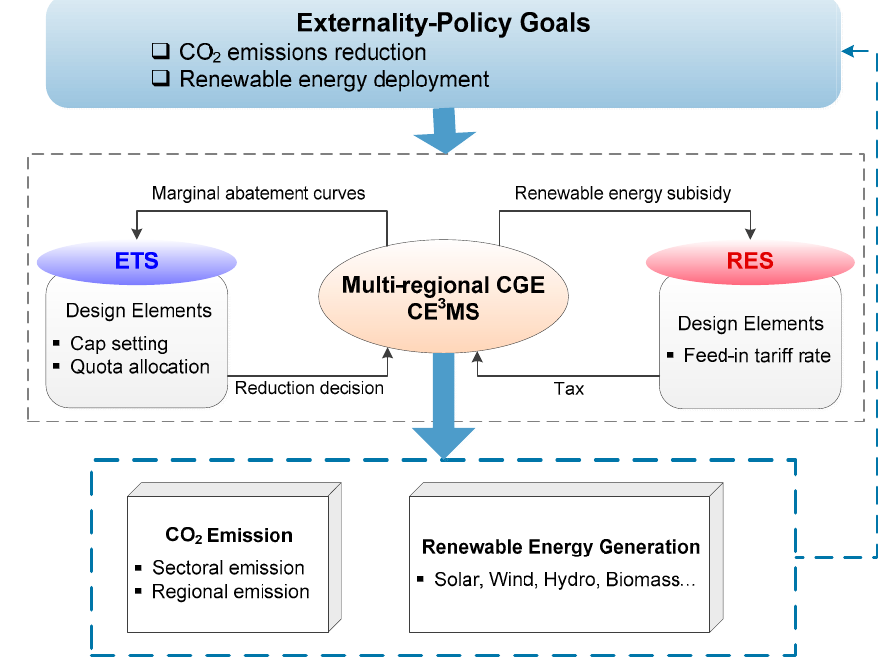
Figure 2. Framework for combining ETS and RES policies in CE 3 MS.